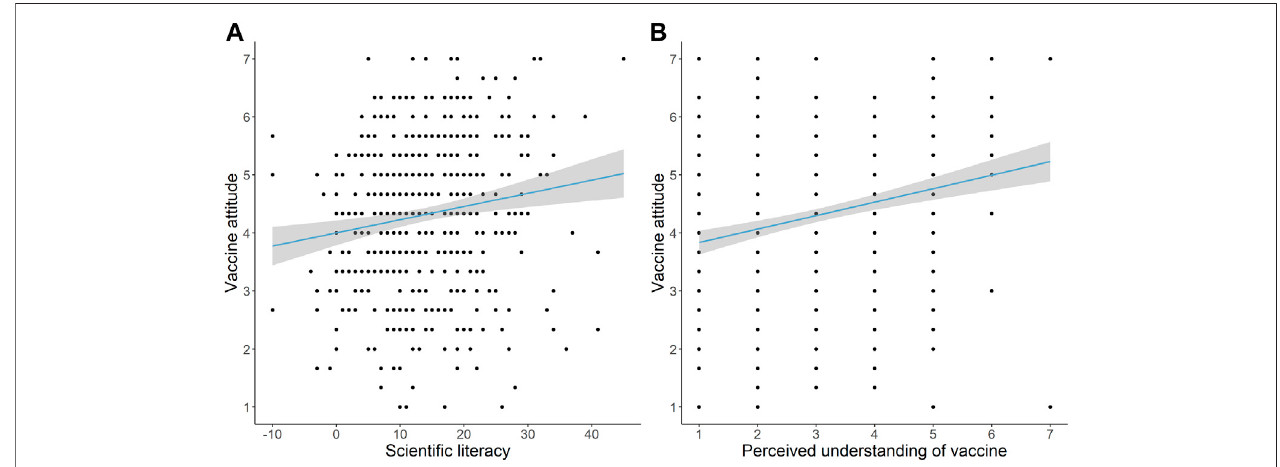
FIGURE 2 | (A) Scatterplot of the relations between scienti fi c literacy and COVID-19 vaccine attitudes. (B) . Scatterplot of the relations between perceived understanding of COVID-19 vaccines and COVID-19 vaccine attitudes. The solid lines represent best- fi tting regression lines. The shaded areas represent the 95% con fi dence interval around the regression line.